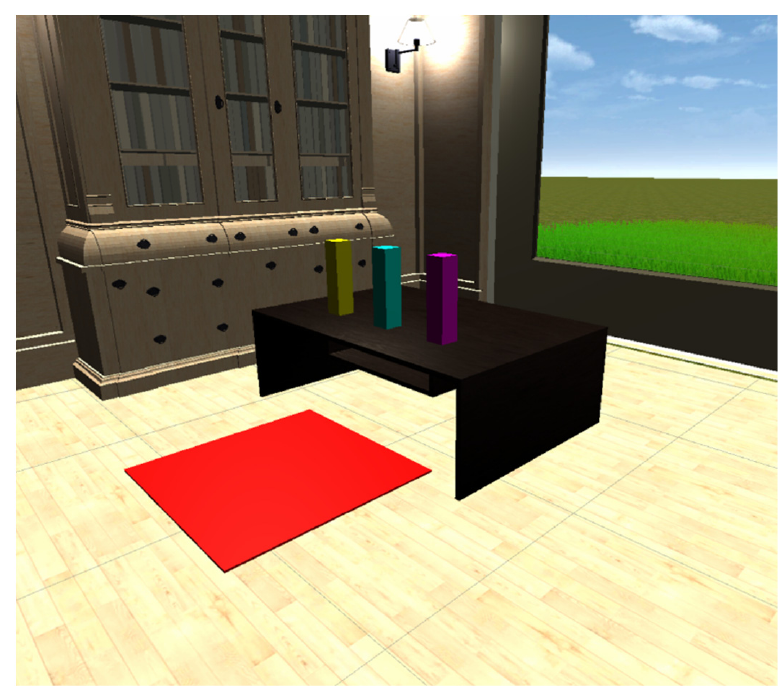
Figure 3. Image of a station in VR which enabled users to pick up, grasp and move blocks.